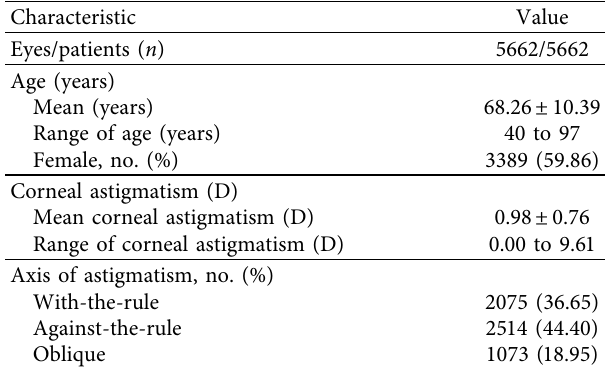
Table 1: Demographic characteristics and clinical findings of the study